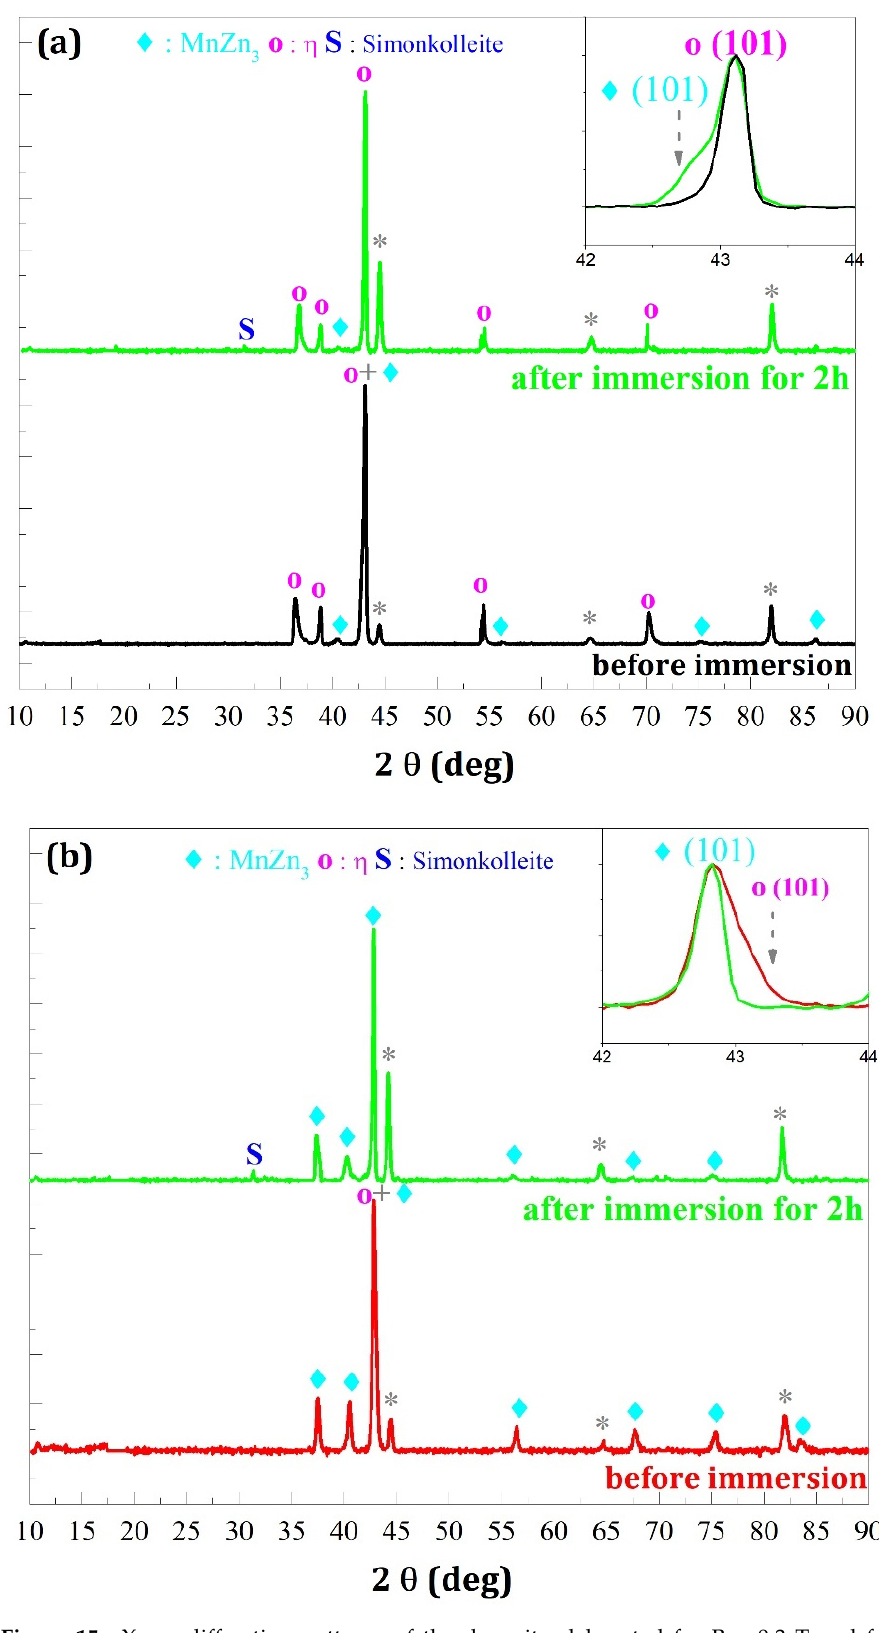
Figure 15. X-ray diffraction patterns of the deposits elaborated for B = 0.3 T and for two imposed potentials ( a ) E = − 1.6 V/SCE and ( b ) E = − 1.8 V/SCE before and after immersion for 2 h in 3.5% NaCl. Simonkolleite (JCPDS 00-007-0155), phases η (JCPDS = 96-901-3473), and MnZn 3 (JCPDS = 96-153-8161).